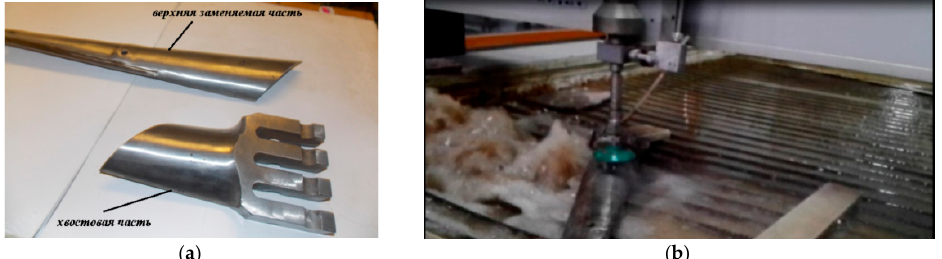
Figure 3. Treatment process: ( a ) Cut blade—an implant; ( b ) Hydroabrasive cutting installation APW 1525BA (Water Jet).